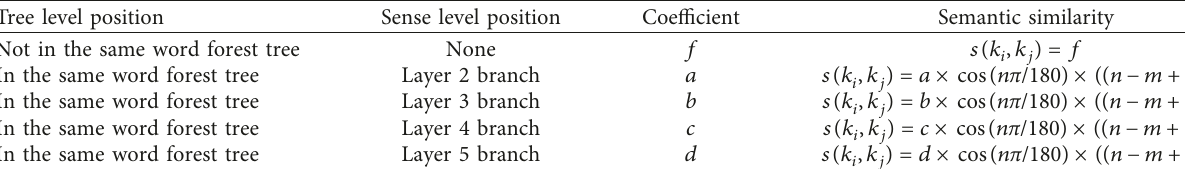
Table 3: Similarity calculation method [28].